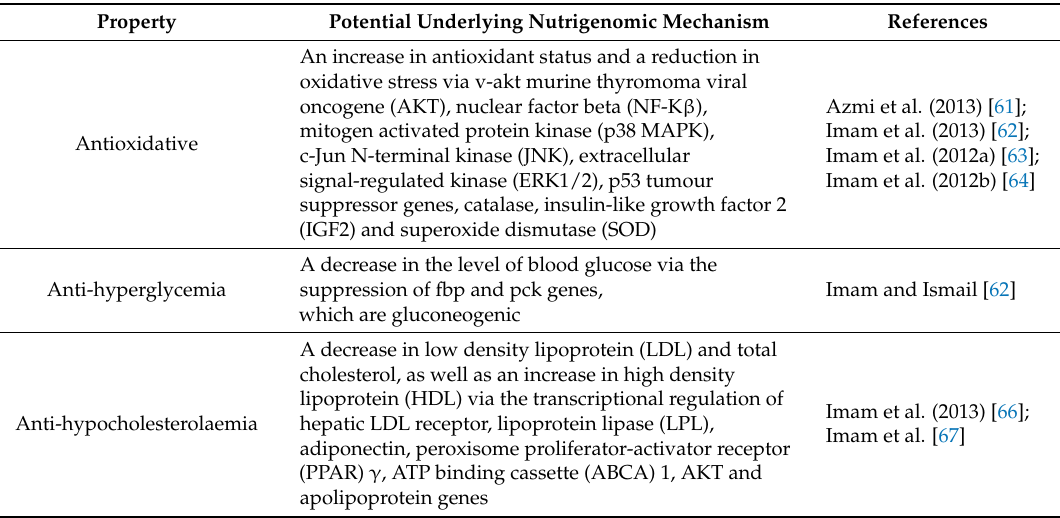
Table 4. Summary of some important nutrigenomic mechanisms involved in brown